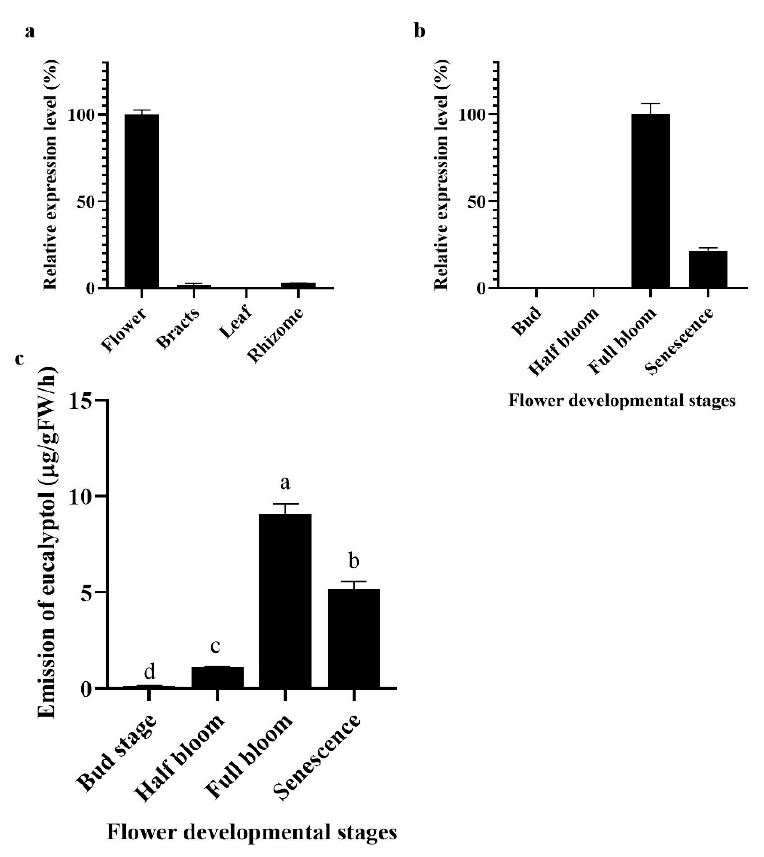
Figure 4. Expression analysis of HcMYB132 in different tissues. ( a ) Relative expression level of HcMYB132 in different parts; ( b ) different flower development stages of H . coronarium, results are shown as a percentage with a maximum value set to 1 (100%); ( c ) emission level of eucalyptol during flower development stages, data are shown as ± SEM of three to five repeats. Lowercase letters represent statistically significant differences at p < 0.01, according to least significant difference (LSD).